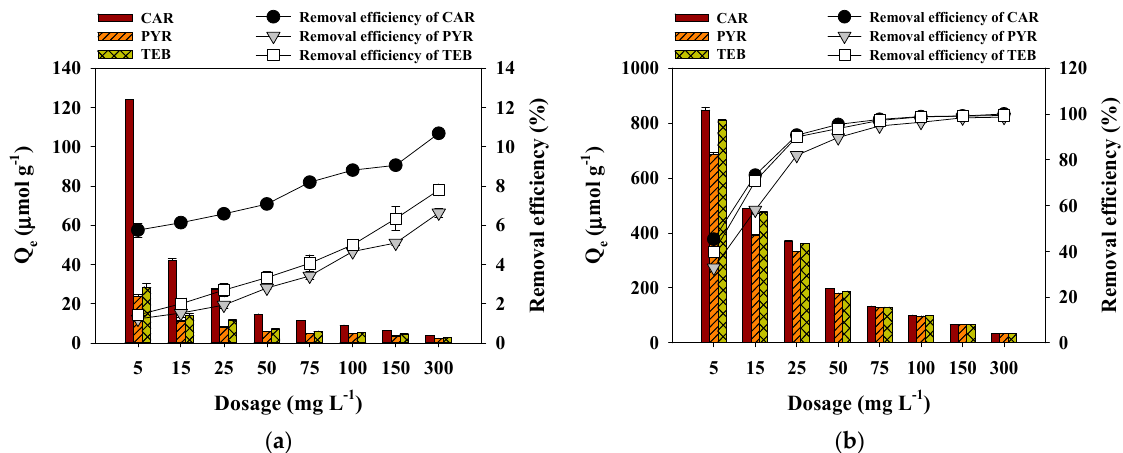
Figure 4. Effects of adsorbent dosages on the removal efficiency of CAR, PYR, and TEB by ( a ) PSB and ( b ) PSB OX-A (agitation speed = 150 rpm; initial concentration of each fungicide = 10 μ M; contact time = 24 h; temperature = 25 °C; pH = 7.0).